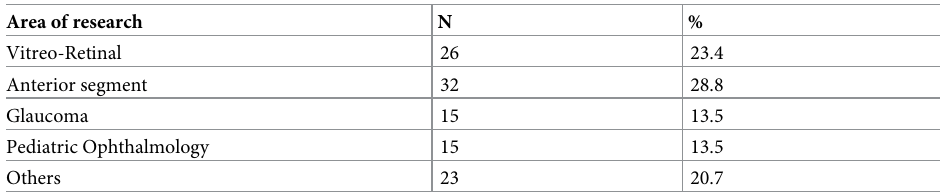
Table 5. Broad areas of research